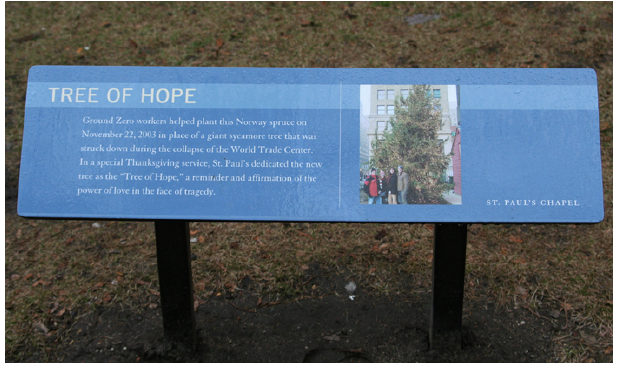
Fig. 3 . Tree of Hope interpretive sign near “Ground Zero.” Photo: K. G.